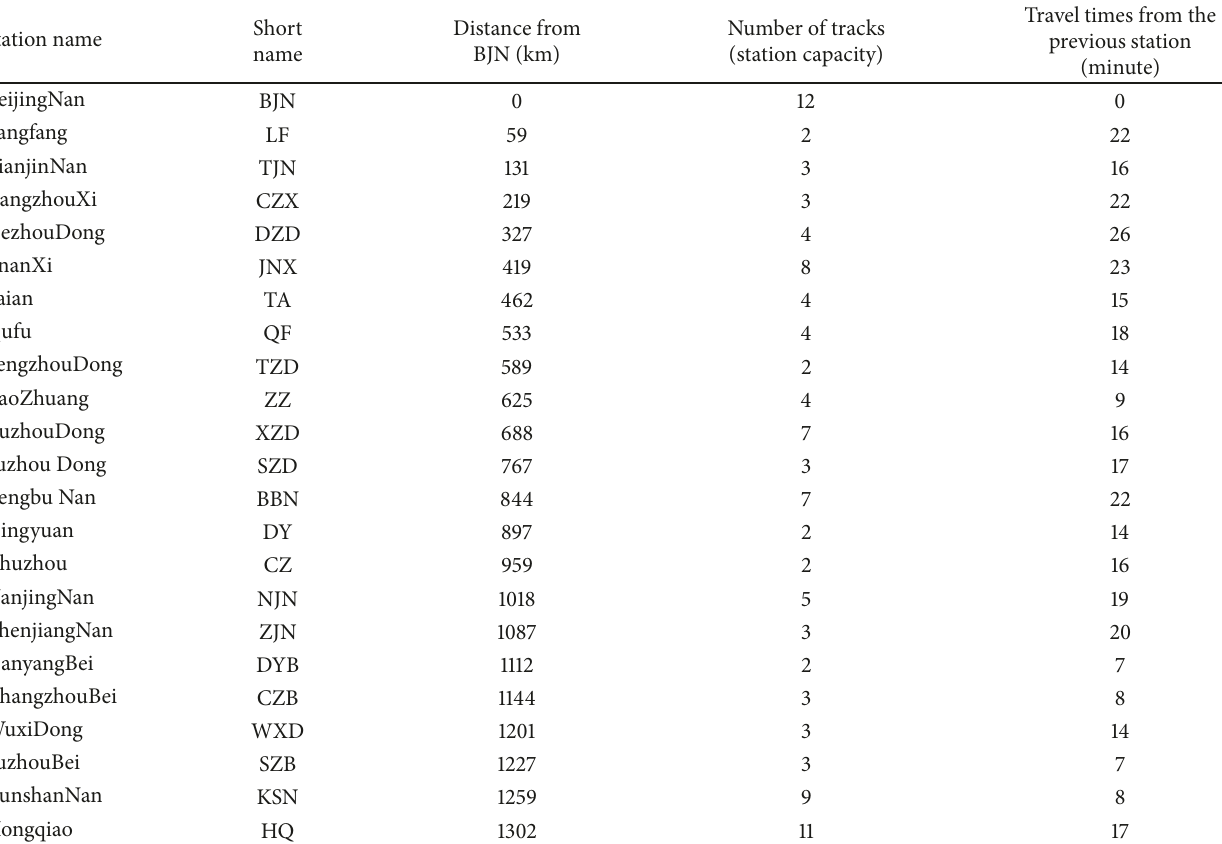
Table 2: Parameters related to infrastructures.